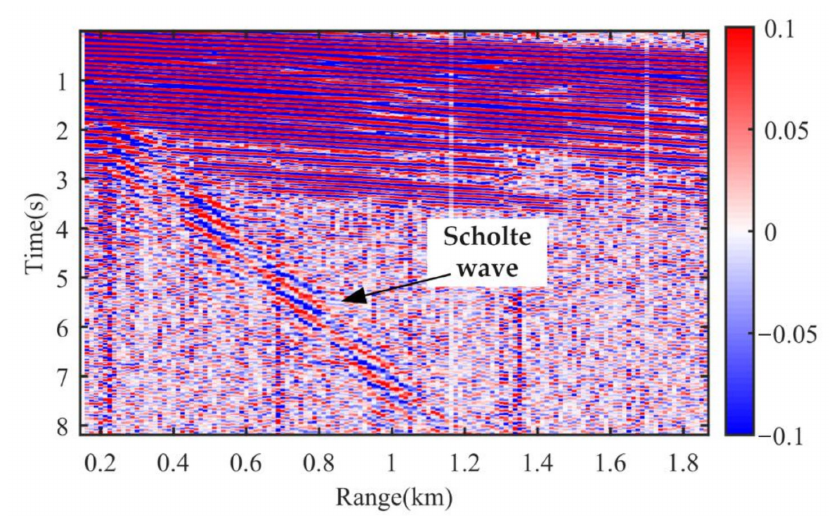
Figure 9. Signals recorded by a single